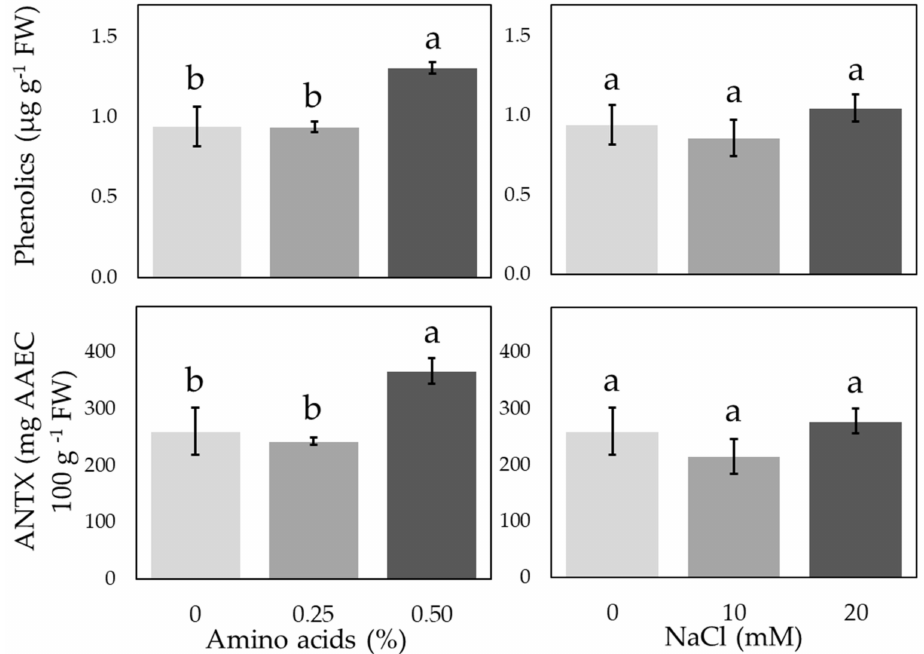
Figure 2. Soluble phenolic content and total antioxidant capacity (ANTX) of peppermint plants grown hydroponically in a floating system on a nutrient solution supplemented either with 0, 0.25, or 0.50% of a commercial amino acid solution (Amino16 ® ) or 0, 10, and 20 mM NaCl. Each column is the mean of three replications with 16 plants per replication. Different letters on the columns in each treatment (amino acids or NaCl solution) indicate significant differences between mean, according to the least significant differences test (LSD) at p < 0.05.